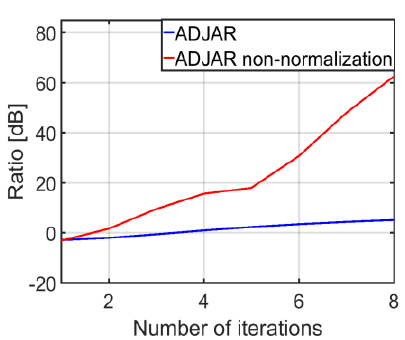
Figure 10 Ratio [dB] between the powers of 𝑎̂ 𝐴𝑑𝑗𝑎𝑟 (𝑡) and 𝑎̂ 𝐴𝑣 (𝑡) against the number of iterations for two cases: blue line for the original ADJAR algorithm and red line for the same iterative algorithm considering all fixations with non- normalized